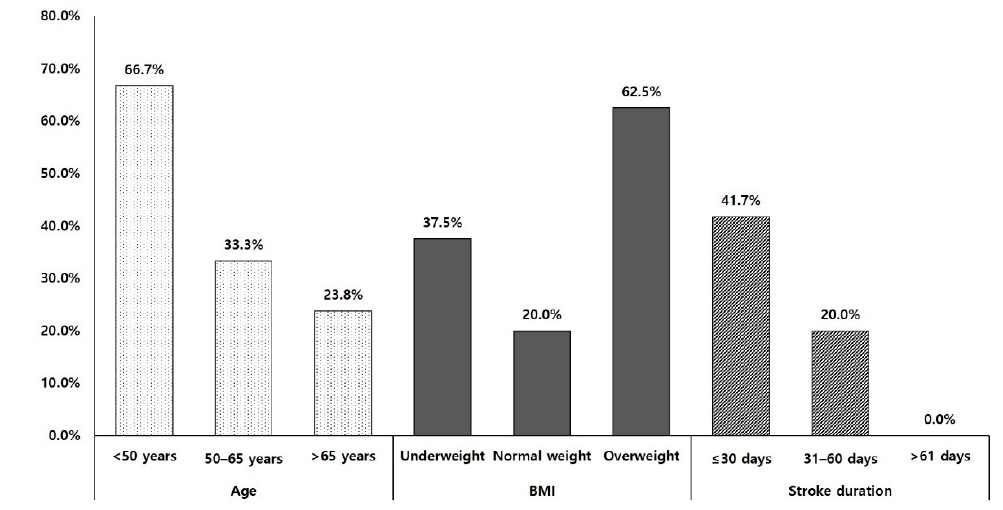
Figure 1. Rate of good responders. BMI: body mass index.